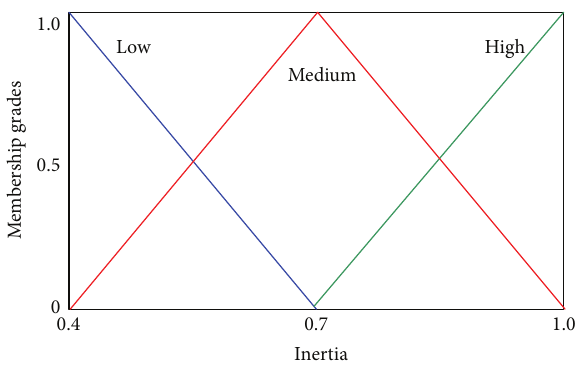
Figure 3: Membership function plots for fuzzy sets corresponding to low , medium , and high inertia ( 𝜔 ).